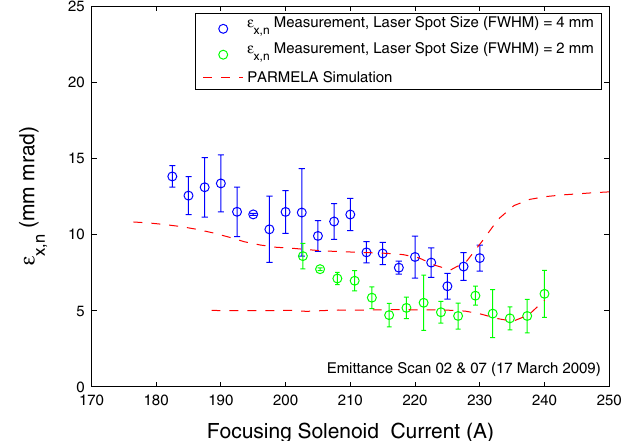
FIG. 7. Emittance measurement with respect to the laser spot size: (blue) (cid:2) laser ¼ 4 mm , Q ¼ 1 : 28 nC , E ¼ 5 : 5 MeV , train length ¼ 200 ns ; (green) (cid:2) laser ¼ 2 mm , Q ¼ 1 : 1 nC , E ¼ 5 : 7 MeV , train length ¼ 200 ns .